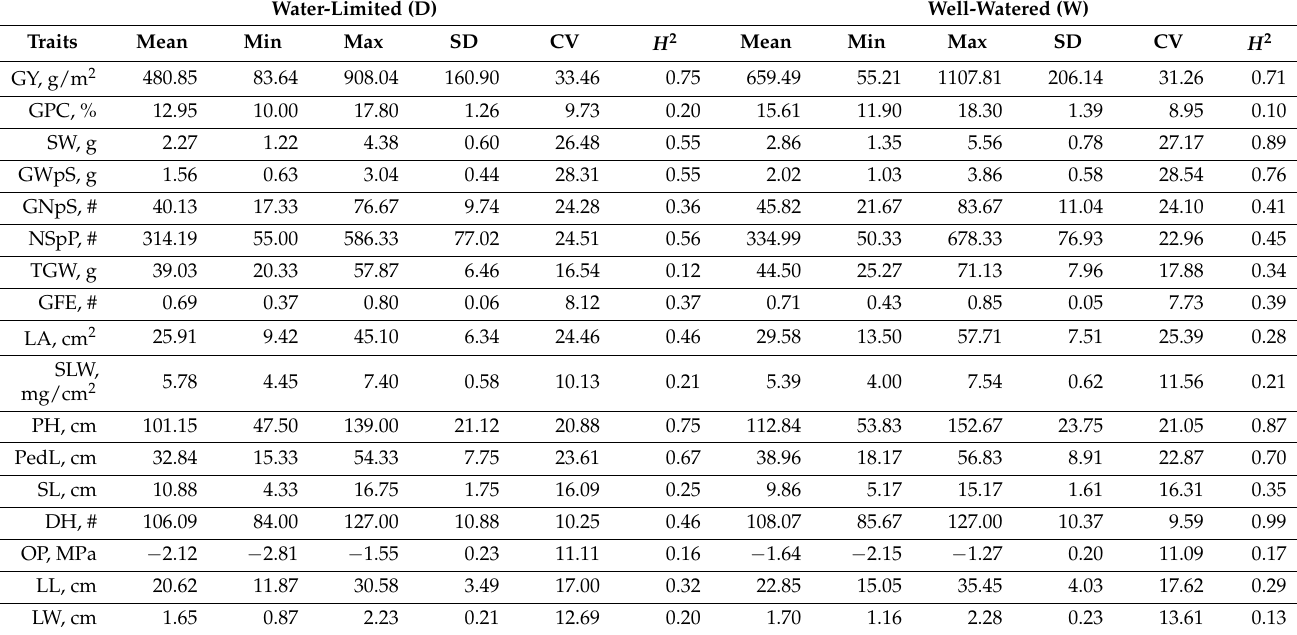
Table 1. Descriptive statistics of phenotypic traits measured under varying water supply in 232 ac- cessions. Mean, minimum (Min), and maximum (Max) values, standard deviation (SD), coefficient of variance (CV), and heritability estimates ( H 2 ) for grain yield (GY), grain protein content (GPC), spike weight (SW), grain weight per spike (GWpS), grain number per spike (GNpS), number of spikes per plot (NSpP), thousand-grain weight (TGW), the efficiency of grain filling (GFE), leaf area (LA), specific leaf weight (SLW), plant height including spike (PH), peduncle length (PedL), spike length (SL), days-to-heading (DH), Osmotic potential (OP), Flag leaf length (LL), Flag leaf width (LW), (# = number).